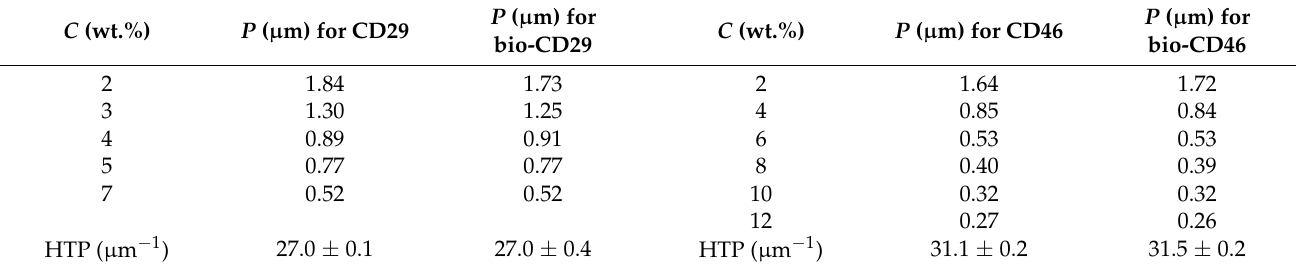
Figure 2. Textures of the Grandjean–Cano spherical wedge cells acquired for the four chiral dopants mixtures, CD29 and bio-CD29 in the 2 wt.% concentration ( left ) and CD46 and bio-CD46 in the 10 wt.% ( right ). Color similarity quantitatively highlights the pitch comparability between the respective commercial and bio-reachable chiral dopants mixtures. Table 1. Pitch dependence on concentration of chiral dopants CD29 and CD46 in the commercial and bio-reachable form in E7 nematic host. The HTP of each chiral dopant obtained from the slope of the dependence of reverse pitch vs. concentration are shown in the last